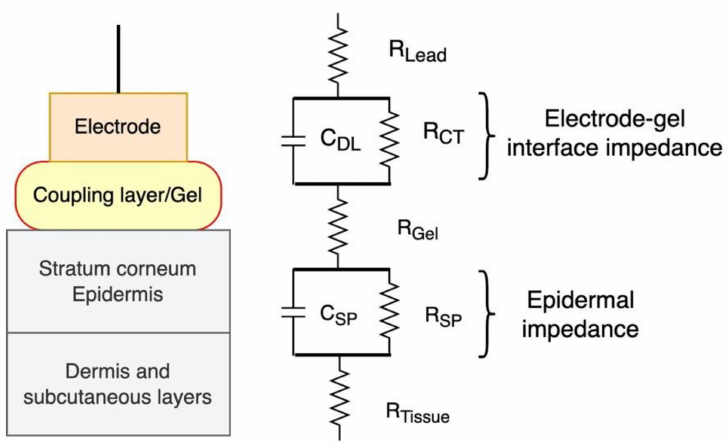
Figure 7. Electrical equivalent circuit of skin electrode interface